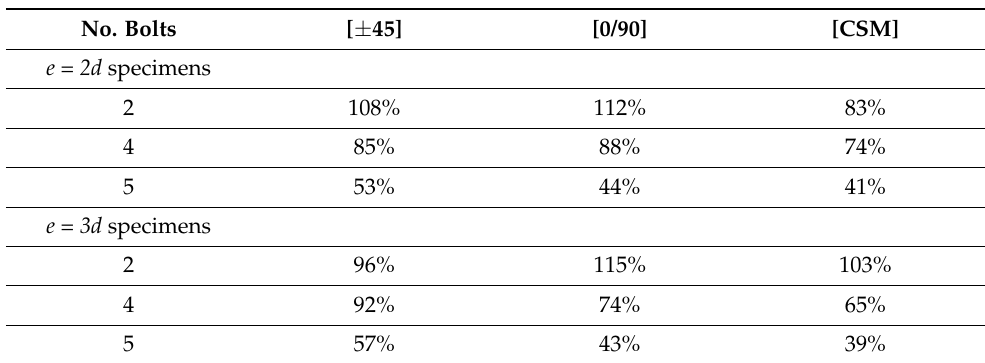
Figure 10. Average ultimate load of specimens. Table 6. Strengthening effect of GFS.